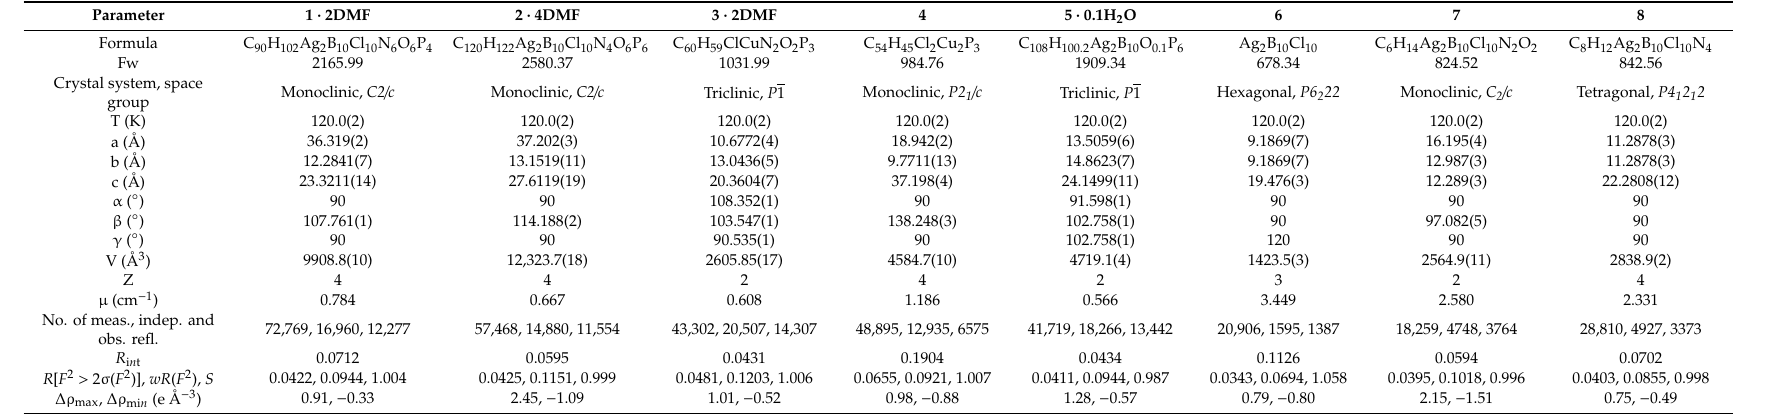
Table 1. X-ray crystallographic data for complexes 1 – 8